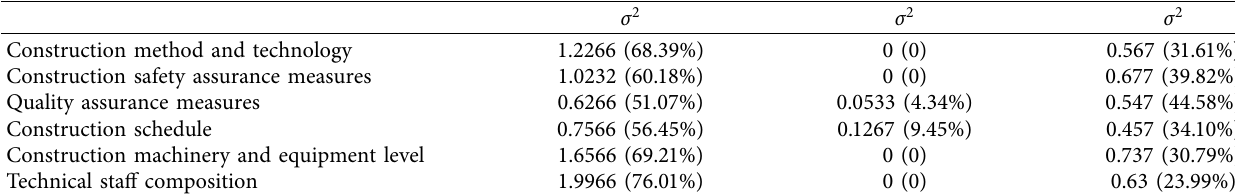
Table 6: p × r G-study variance component estimation and percentage of design evaluation.